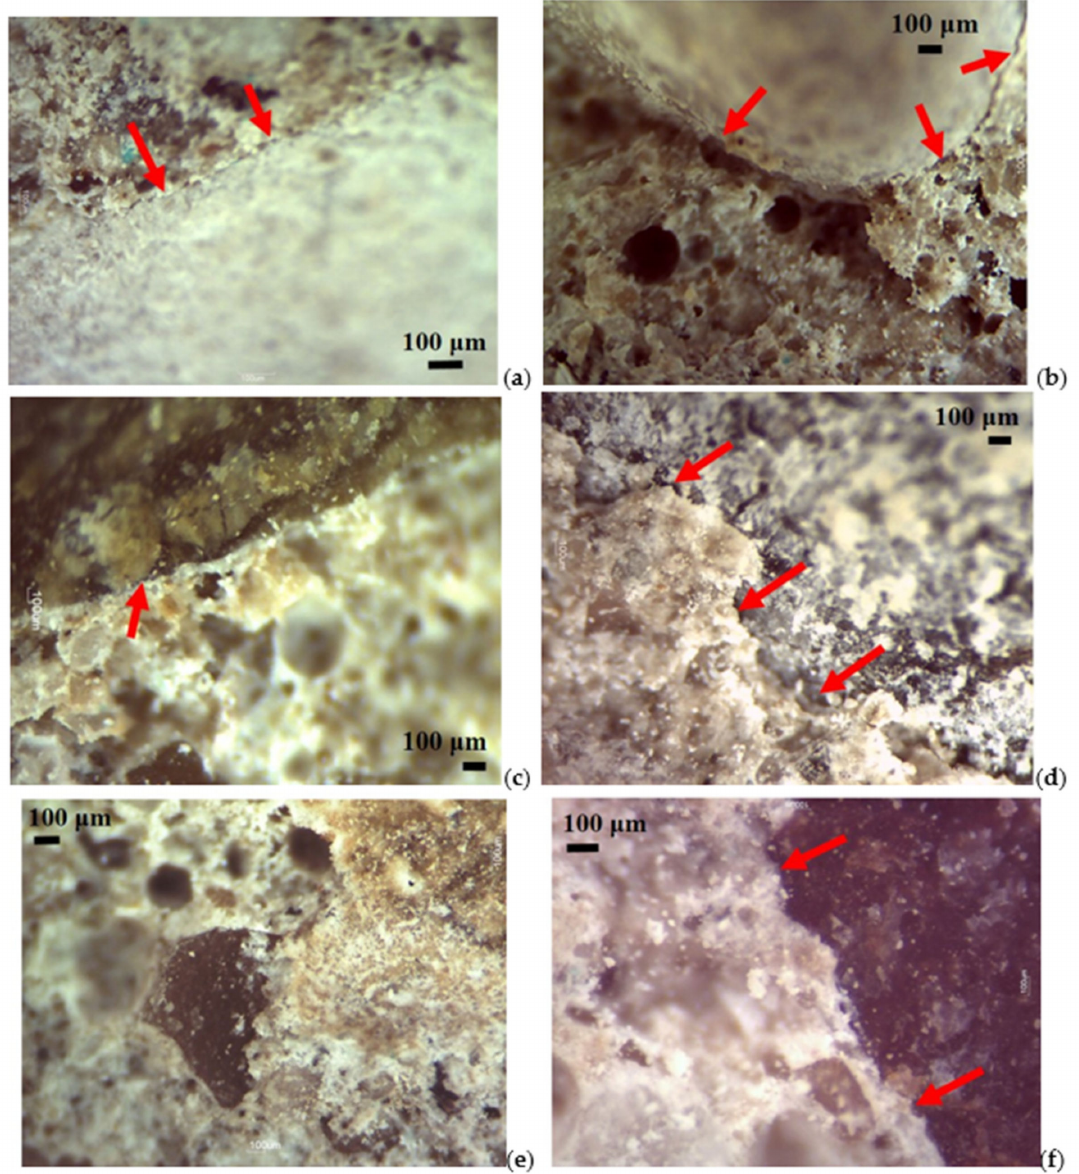
Figure 7. Photo imaging obtained by a stereomicroscope at 1.5 × magnification: ( a , b ) round calcareous contact edge; ( c – e ) round metamorphic contact edge; ( e ) crushed calcareous aggregate contact edge; ( f ) crushed porphyry aggregate contact